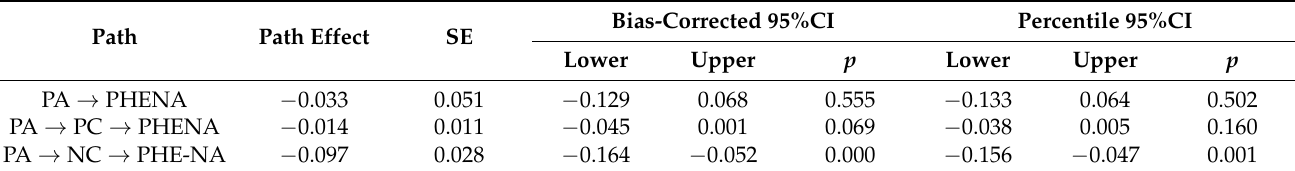
Table 3. Standardized Bootstrap Mediation Effect